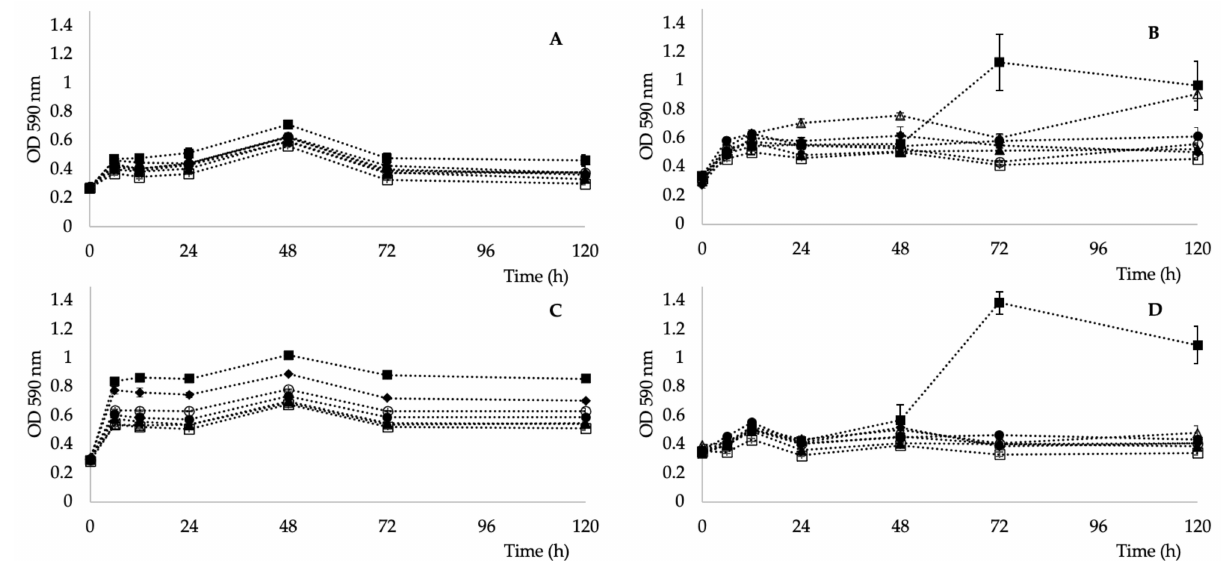
Figure 5. Well color development of individual groups of substrates for Kocuria sp. 101 ( A ), 208 ( B ), 301 ( C ), and 401 ( D ) of alcohols ( ), amines ( (cid:52) ), amino acids ( (cid:78) ), carboxylic acids ( (cid:3) ), esters ( (cid:4) ), (cid:35) hydrocarbons ( • ), polymers ( (cid:7)